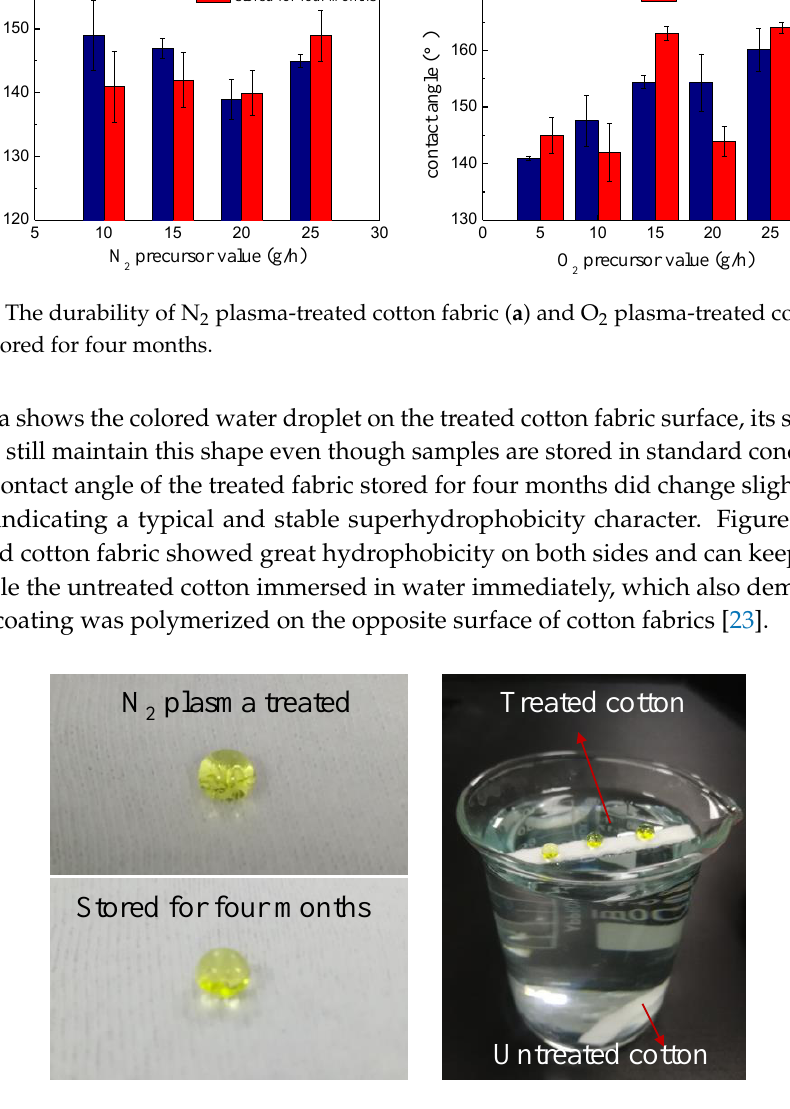
Figure 11. The pictures of a drop of colored water on the treated samples.